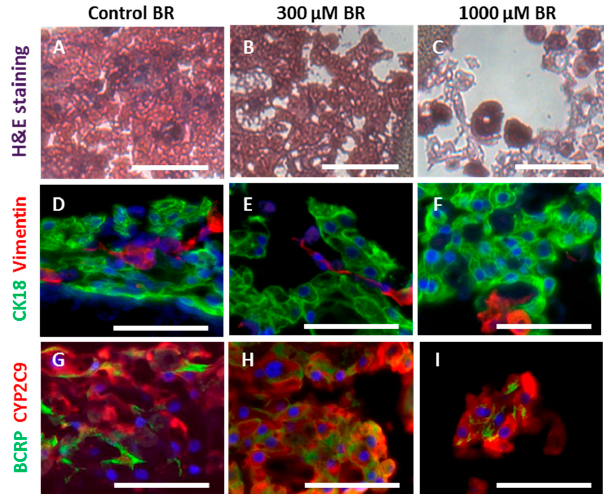
Figure 6. Histological and immunohistochemical analysis of primary human liver cells cultured